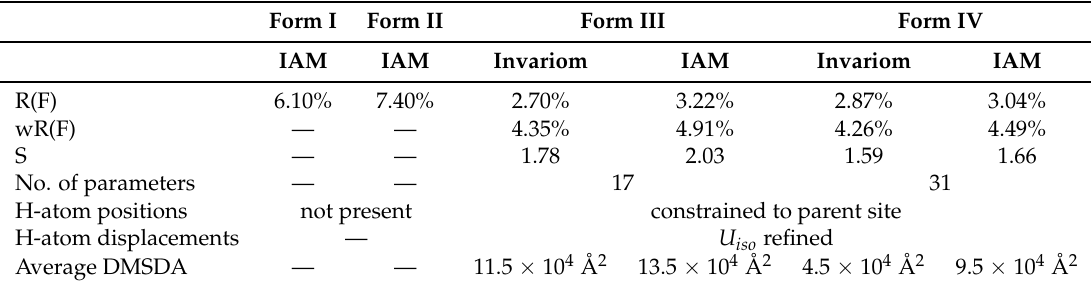
Table 3. Figures of merit for the independent atom model (IAM) and the Invariom model (new Forms III and IV). Form I Form II Form III Form IV IAM IAM Invariom IAM